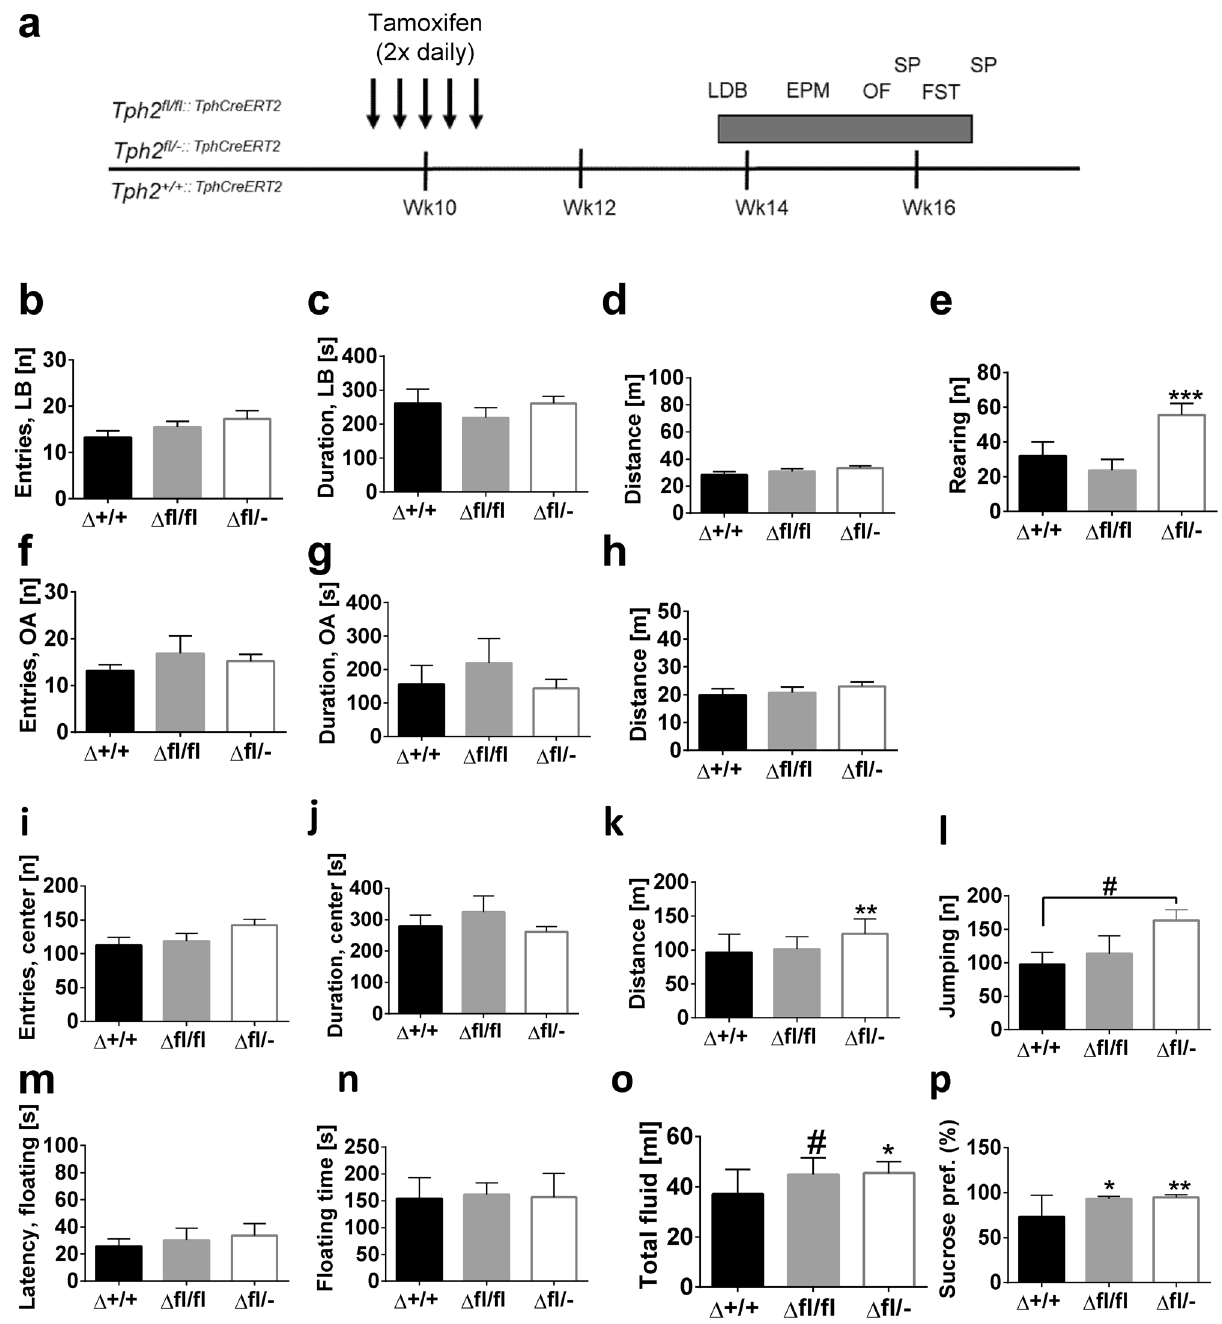
Figure 3. Lack of effects on anxiety- and depression-like but increased exploratory behavior in Tph2 icKO mice based on hemizygous genetic predisposition ( a ) Timelines for behaviour testing; ( b )–( e ) LDB: light box visits, time in light box, total distance and vertical rearings; ( f )–( h ) EPM: open arms visits, time in open arms and total distance; ( i )–( l ) OFT: center visits, time in center, total distance and jumping behavior; ( m ),( n ) FST: latency to float and floating duration; ( o ),( p ) SPT: total fluid consumed and sucrose preference. Data are shown as mean ± SEM. #0.05 < p < 0.1, ** p < 0.01 and *** p <